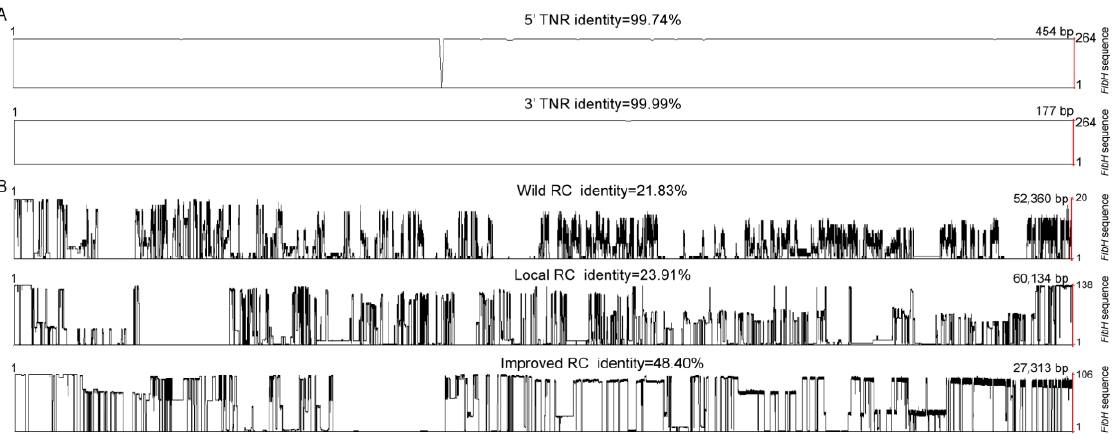
Figure 3. Conserved analysis of the FibH gene. ( A ) Similarity analysis of TNR of 264 FibH sequences. 5′ or 3′ TNR, 5′ or 3′ terminal non-repetitive. ( B ) Similarity analysis of RC of wild silkworms, local and improved strains. RC, repetitive core.